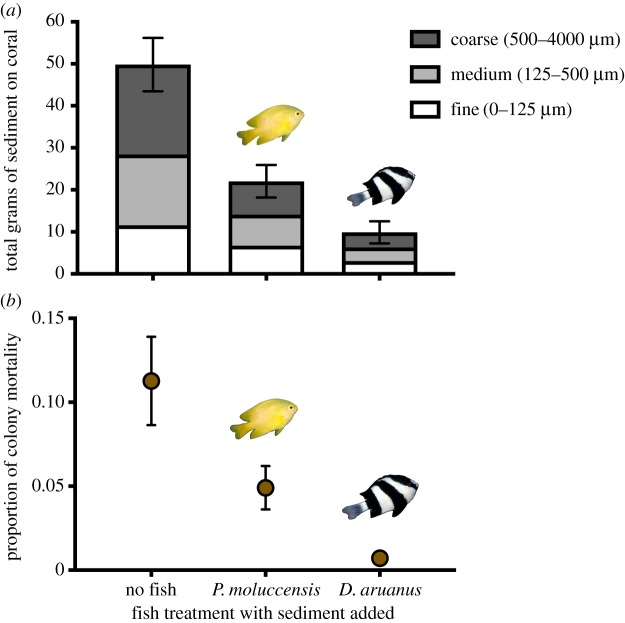
(a) Remaining sediment on P. damicornis colonies (approx. 13.5 cm diameter) after 28 days of approximately 14 g of sediment deposition in experimental aquaria sediment added corals. n = 12 coral treatments (except corals with sediment added, in which a colony died on day 25 and was removed from analysis). Treatments included colonies with different fishes (no fish, three P. moluccensis and three D. aruanus) and sediment (no sediment and with sediment added at a rate of approximately 100 mg cm−2 d−1 for 28 days). Error bars show s.e. As values for no sediment treatments were very low (less than 0.29 g), they were not included in this figure. Bar colours represent grain size fractions as follows: dark grey is coarse (500–4000 µm), grey is medium (125–500 µm) and white is fine (0–125 µm) sediment. (b) Average levels of whole P. damicornis colony partial mortality, measured after 28 days of experimental fish and sediment treatments.